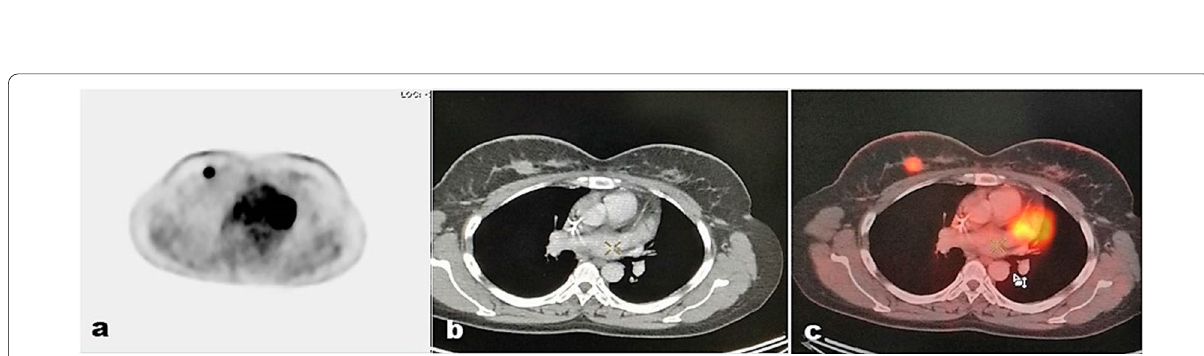
Fig. 3 35 years old patient with recently diagnosed right sided luminal A breast carcinoma. TLR corresponding CT axial cut in b showing a speculated isodense enhancing soft tissue mass at the upper quadrant of the right breast. It measures about 5.2 2.5 cm. b Fused PET/CT axial cut shows that the lesion is FDG avid displaying SUV max ~ ×